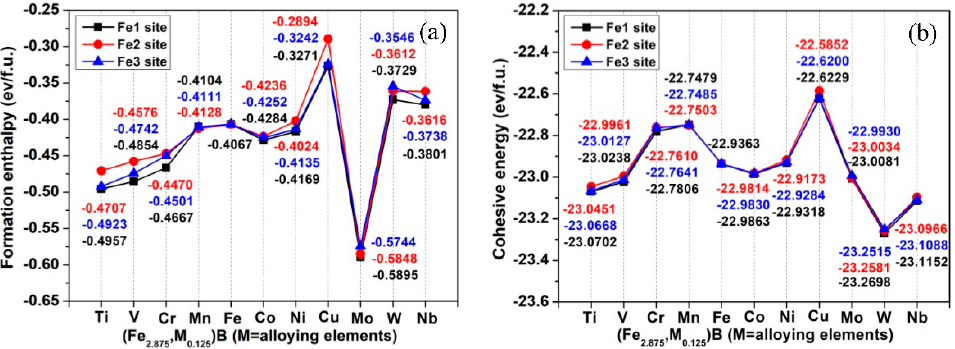
Figure 4. ( a ) Formation enthalpy and ( b ) cohesive energy of Fe 3 B and alloyed Fe 3